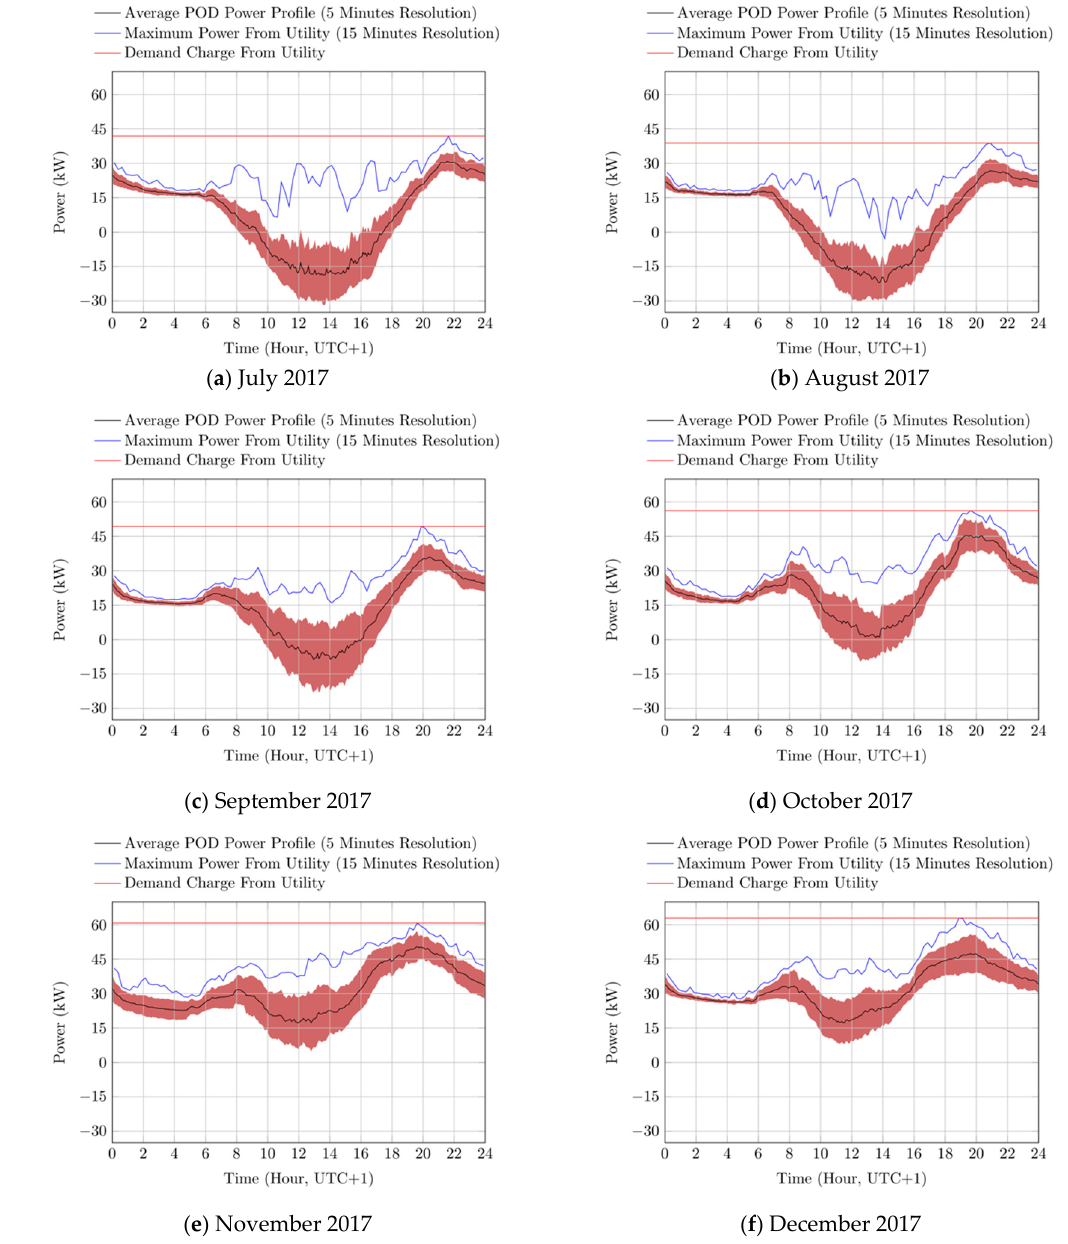
Figure 4. Monthly average and peak power data of the user’s point of delivery (POD), recorded from July to December 2017, as depicted from sub-figure ( a ) to sub-figure ( f ), respectively. Positive and negative values represent power flows from the grid and to the grid, respectively. Data are sampled every 10 s and the averages are recorded every 5 min. The red area represents the standard deviation of the measured POD power flows. UTC: Universal Time Coordinated.